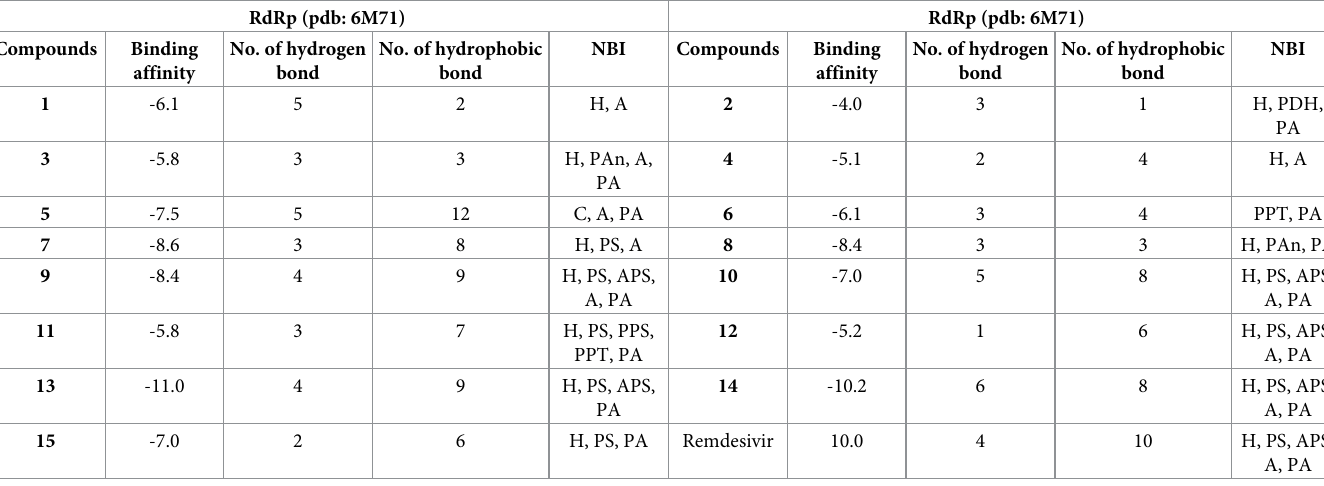
Table 2. The binding energy of the cytidine derivatives against RdRp.